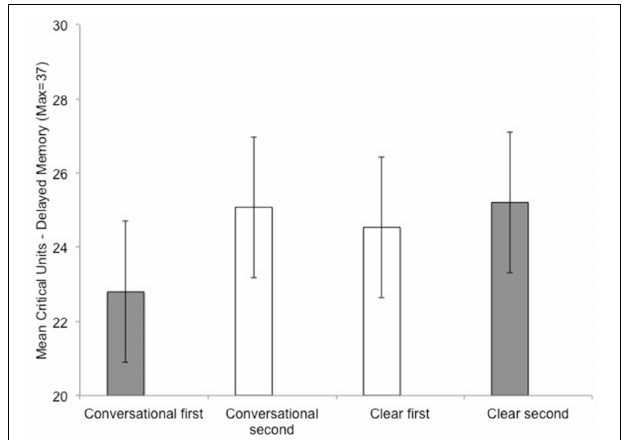
FIGURE 4 | Comparing learning effects with listening condition (conversational and clear speech) on delayed memory performance for the Quiet/Noise groups combined. First/second indicates the order in which the participant performed that experimental listening condition. The color of the bars differentiates the between-subject listening order in which they experienced the listening condition: Gray bars represent the subgroup of participants who listened in conversation first/clear second; white bars represent the subgroup of participants who listened in clear first/conversation second. Error bars are the standard error of the